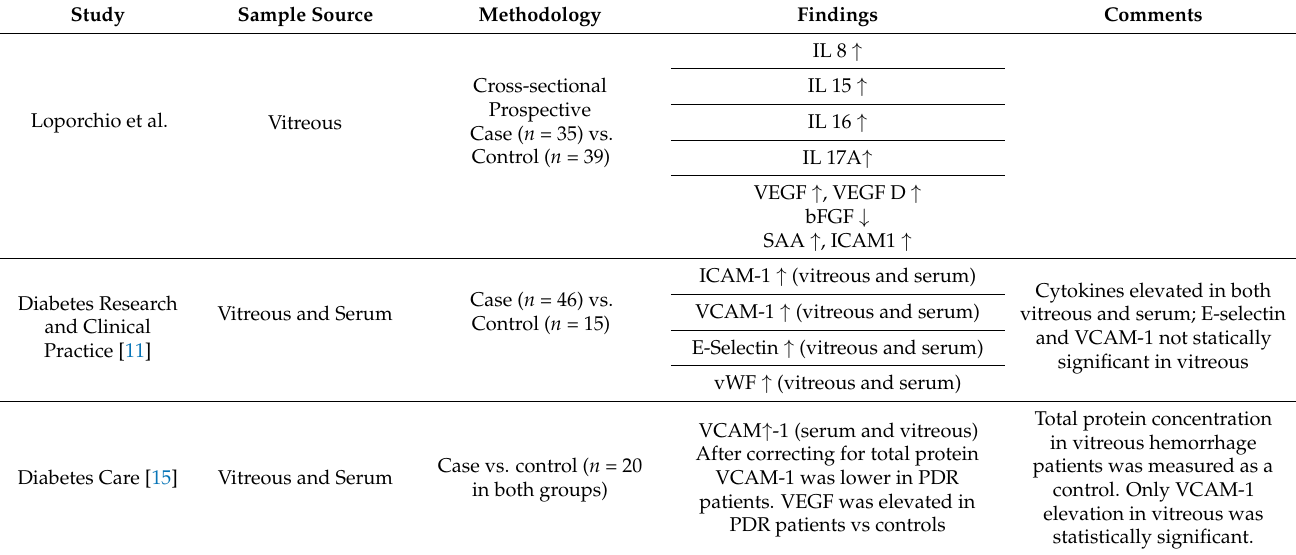
Table 4. Compilation of Cytokines Studies for Proliferative Diabetic Retinopathy.